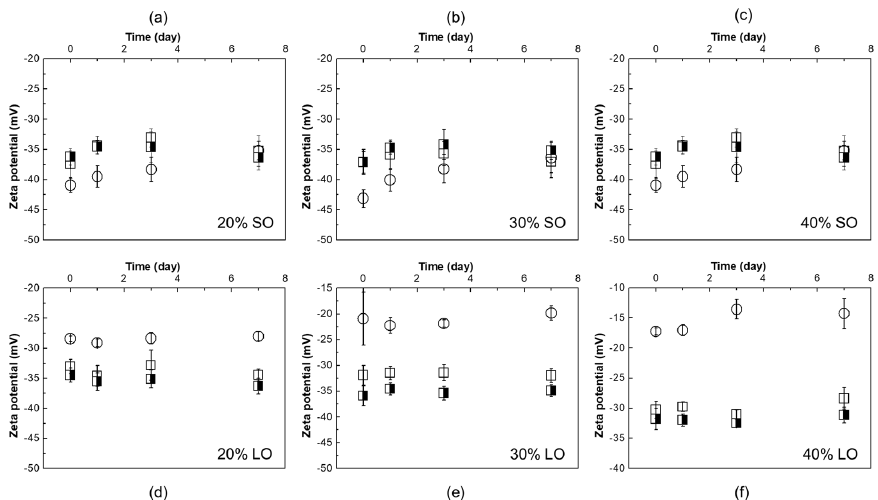
Figure 6. Sauter mean diameter (d 3,2 , full symbols) and span (empty symbols) versus the number of emulsification cycles Figure 10. Zeta potential versus storage time at room temperature (25 °C) for produced emulsions Figure 10. Zeta potential versus storage time at room temperature (25 ◦ C) for produced emulsions Figure 10. Zeta potential versus storage time at room temperature (25 °C) for produced emulsions for emulsions at different oils and oil fractions: ( a ) 20% SO (sunflower oil); ( b ) 30% SO; ( c ) 40% SO; ( d ) 20% LO (lemon oil); (no buffer added) at different oils and oil fractions: ( a ) 20% SO (sunflower oil); ( b ) 30% SO; ( c ) 40% (no buffer added) at different oils and oil fractions: ( a ) 20% SO (sunflower oil); ( b ) 30% SO; ( c ) 40% Figure 10. Zeta potential versus storage time at room temperature (25 °C) for produced emulsions (no buffer added) at different oils and oil fractions: ( a ) 20% SO (sunflower oil); ( b ) 30% SO; ( c ) 40% ( e ) 30% LO; and ( f ) 40% LO. ( d 3,2 -1% WPI (whey protein isolate); d 3,2 -1% BSFPC (black soldier fly protein concentrate); SO; ( d ) 20% LO (lemon oil); ( e ) 30 % LO; and ( f ) 40 % LO. ( 1% WPI (whey protein isolate); 1% SO; ( d ) 20% LO (lemon oil); ( e ) 30 % LO; and ( f ) 40 % LO. ( 1% WPI (whey protein isolate); 1% (no buffer added) at different oils and oil fractions: ( a ) 20% SO (sunflower oil); ( b ) 30% SO; ( c ) 40% d 3,2 -2% BSFPC; span-1%WPI; span-1% BSFPC; span-2% BSFPC). 1% WPI (whey protein isolate); BSFPC (black soldier fly protein concentrate); and 2% BSFPC). 1% SO; ( d ) 20% LO (lemon oil); ( e ) 30 % LO; and ( f ) 40 % LO. ( BSFPC (black soldier fly protein concentrate); and 2% BSFPC). SO; ( d ) 20% LO (lemon oil); ( e ) 30 % LO; and ( f ) 40 % LO. ( 1% WPI (whey protein isolate); 1% BSFPC (black soldier fly protein concentrate); and 2% BSFPC (black soldier fly protein concentrate); and 2% BSFPC).